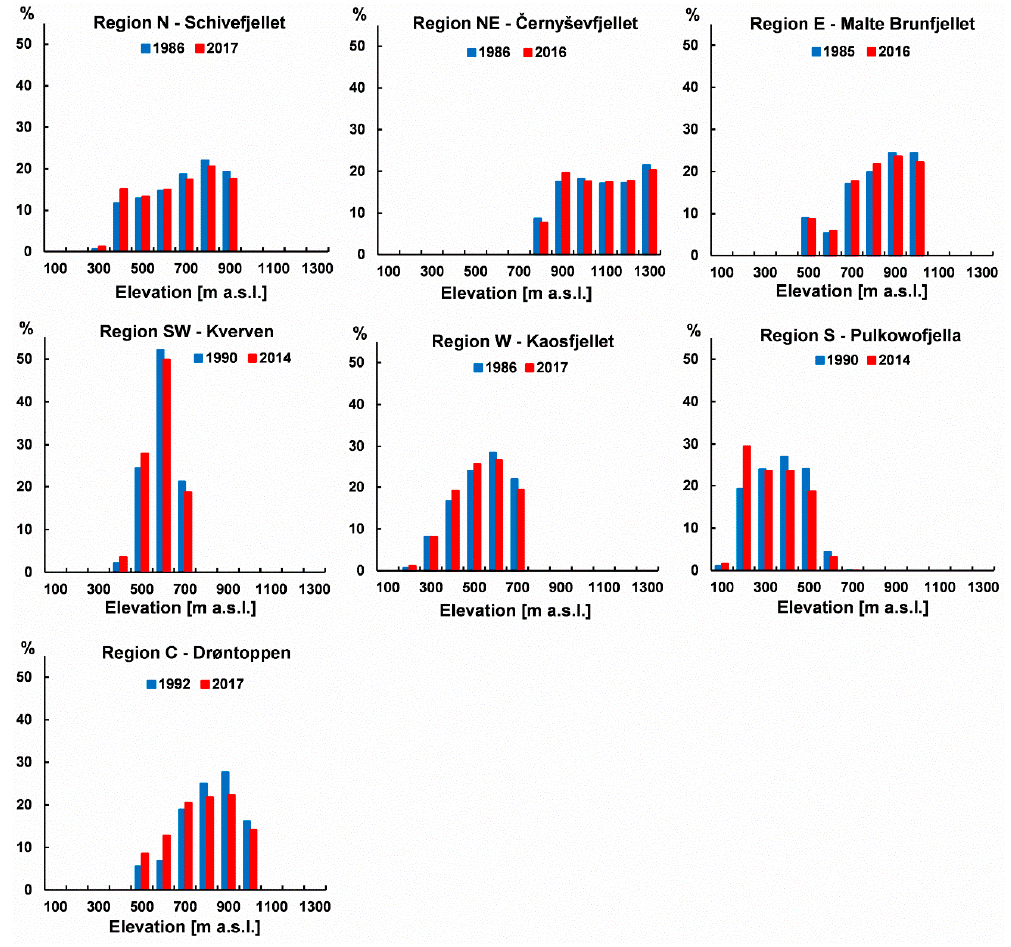
Figure 4. Histograms showing the distribution of nunataks surfaces in different elevation ranges.